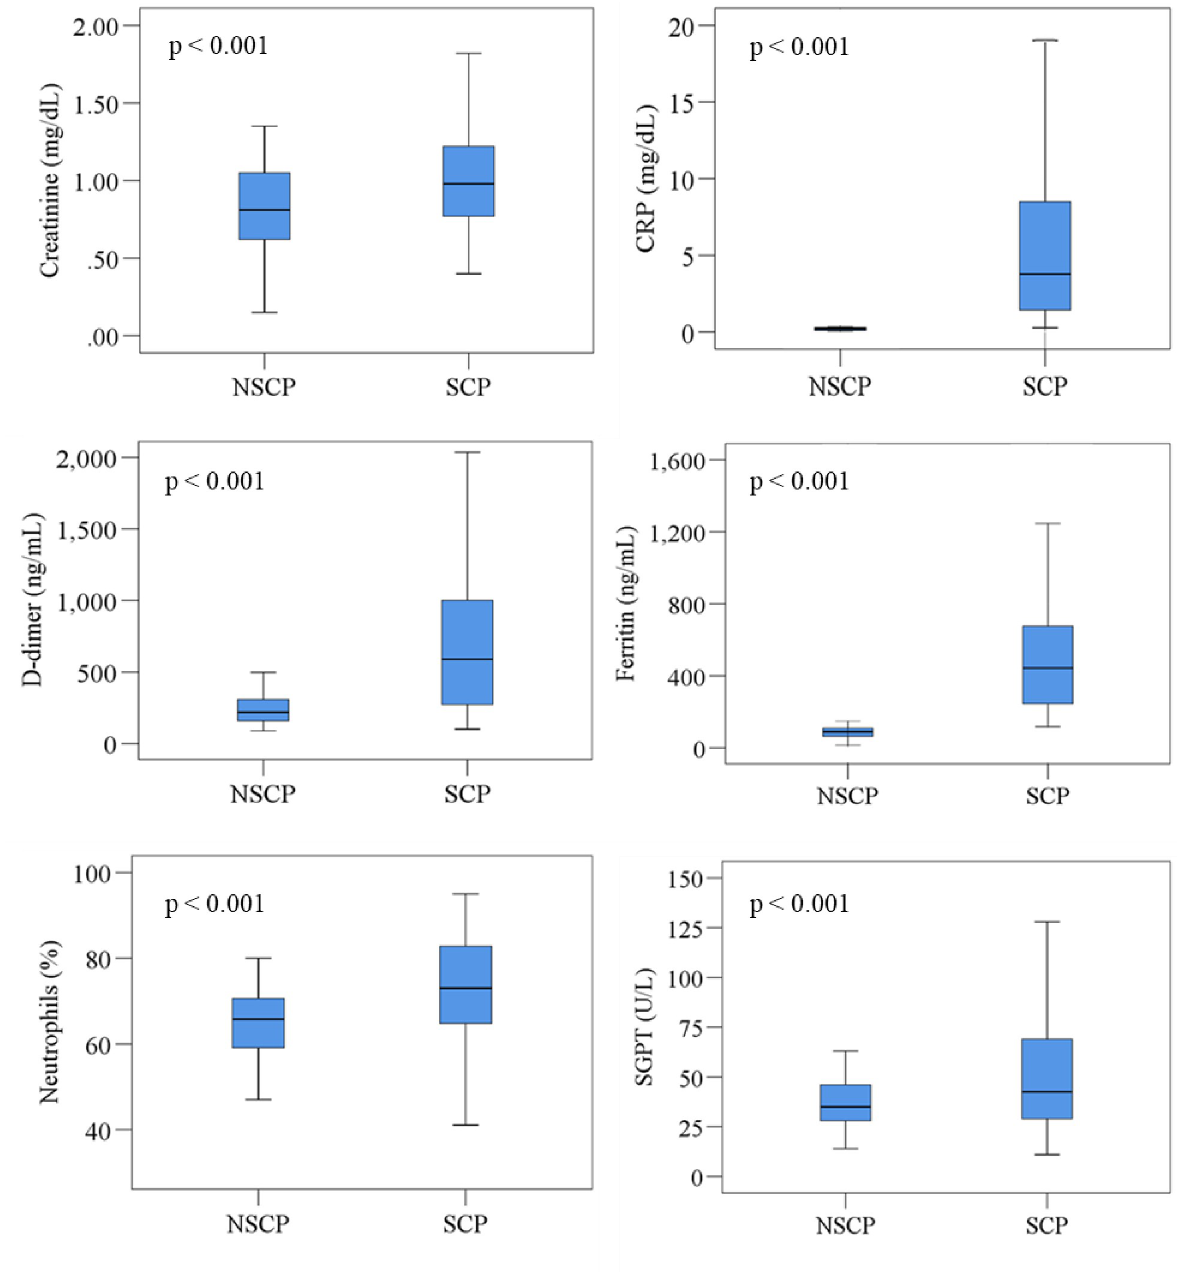
Fig 1. Changes of blood parameters in two different disease states. Independent sample t-test was applied and p < 0.05 was considered as significant at 95% confidence of interval. NSCP, non-severe COVID-19 patients; SCP, severe COVID-19 patients.